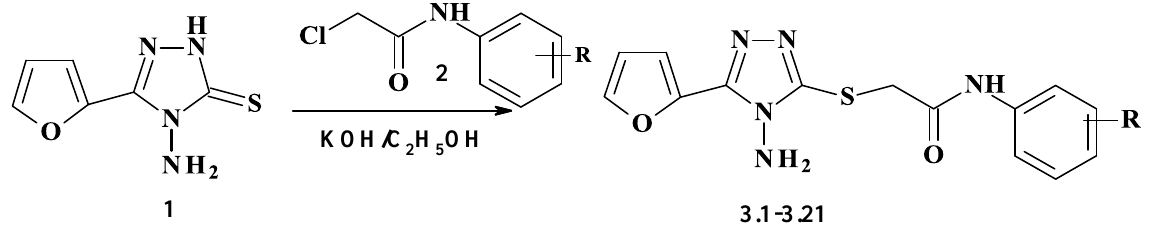
Fig. 2. Synthesis of 2-((4-amino-5-(furan-2-yl)-1,2,4-triazole(4H)-3-yl) -sulfanyl)-N-acetamides ( 3.1-3.21 )